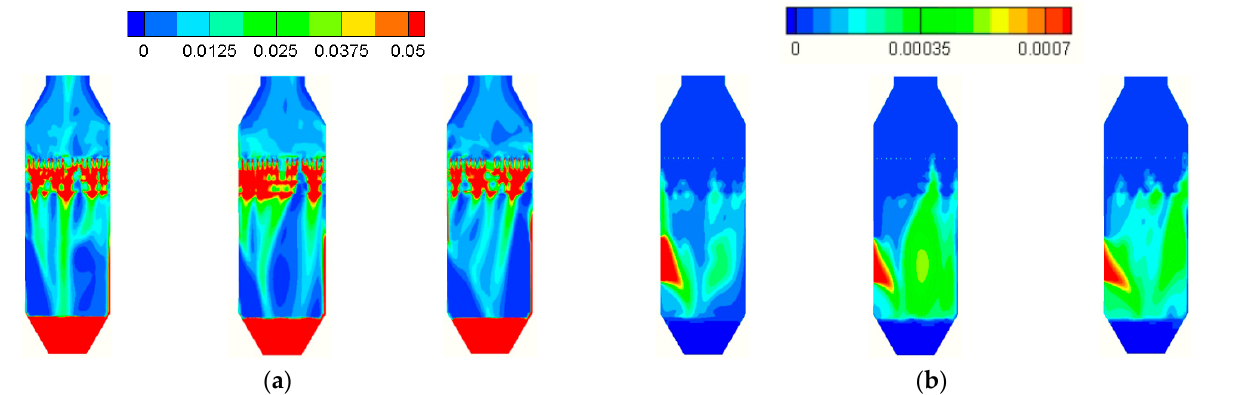
Figure 10. The figure displays ( a ) the liquid volume fraction and ( b ) the mass fraction of SO 2 ( Y SO2 ) for the large-scale tower at different times, by the porous media model.